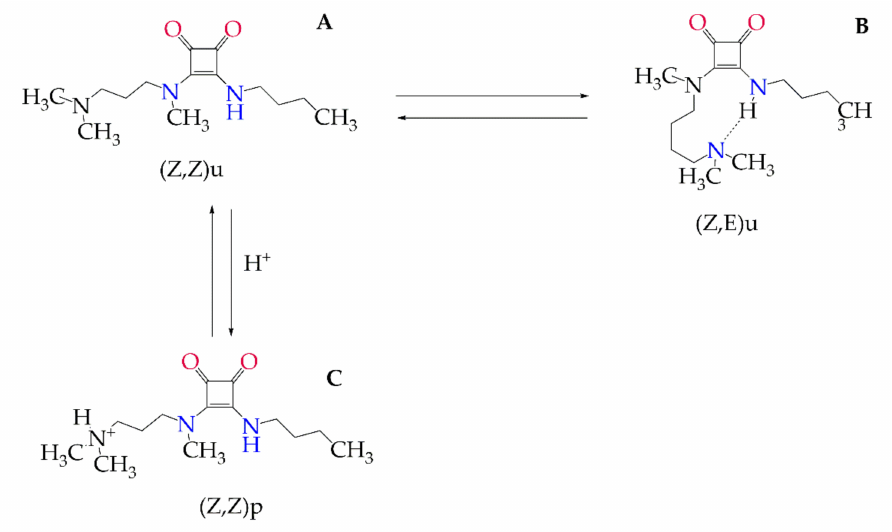
Figure 1. ( A ) Chemical structure of N, N’- Squaramide 17 (S); ( B ) Conformational transitions between ( Z, Z ) and ( Z, E ) Rotamers of Aminosquramide 17 (the subscripts “ u ” and “ p ” indicate neutral and protonated forms, respectively); ( C ) Conformational transitions between ( Z, Z ) and ( Z, E ) Rotamers of Aminosquramide 17 (the subscripts “u” and “p” indicate neutral and protonated forms, respectively) [4]. S comply with Lipinski’s rule of five (Ro5) as they are low molecular mass (267.4 Da); only one hydrogen bond donor; partition coe ffi cient log P = 0.59; polar surface area values < 100 Å 2 ; the